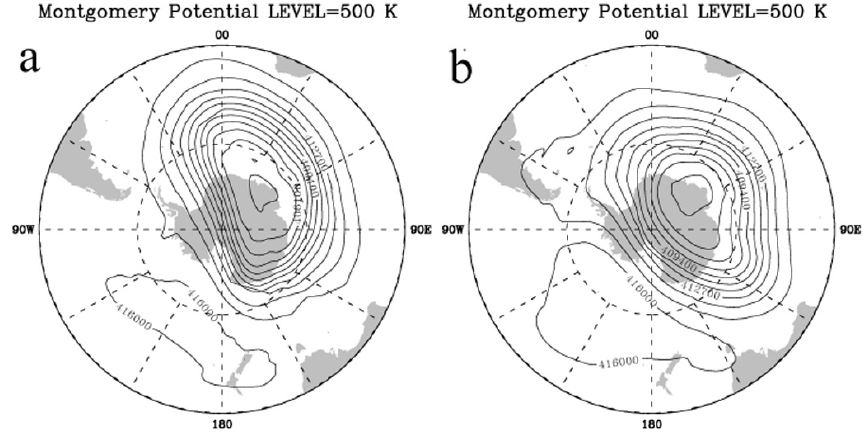
Fig. 2. Distributions of the Montgomery potential field at 500K level from ECMWF: (a) on 12:00UTC 19 November 2005, and (b) on 12:00UTC, 24 November 2005. The unit is m 2 s − 2